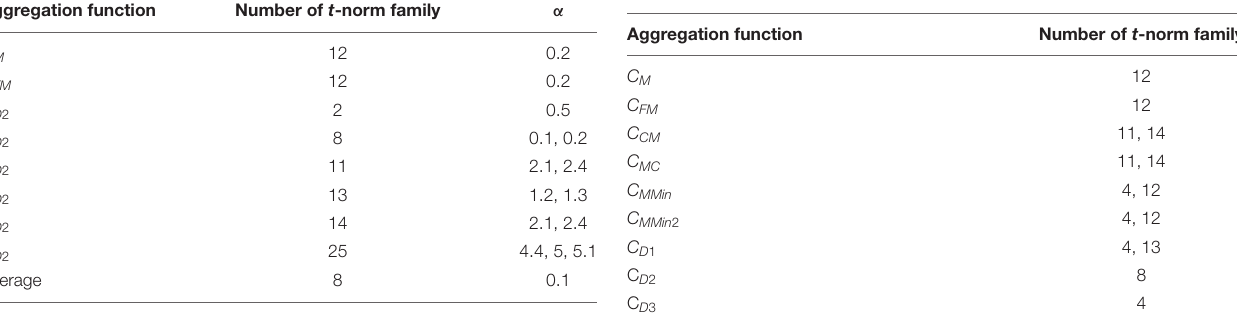
Table 2 supplements the above discussion by showing for which triangular norms and their parameters the classification